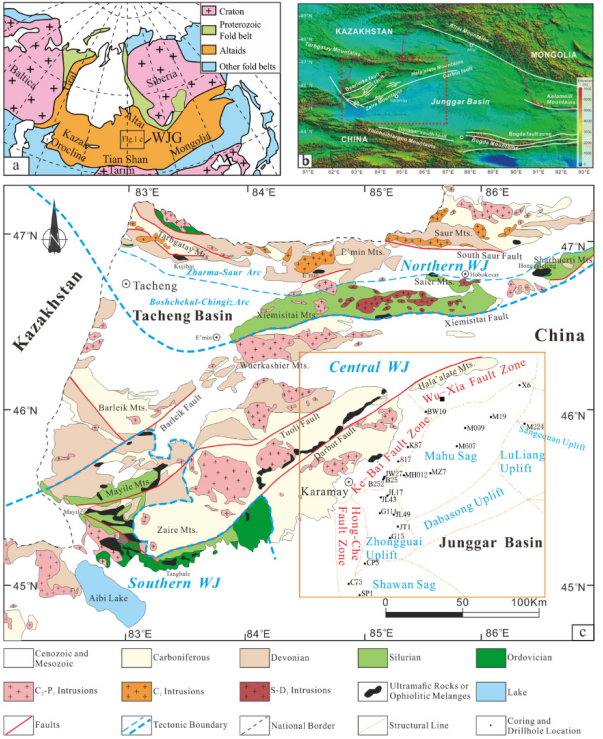
Figure 1. ( a ) Structural diagram of West Junggar and adjacent areas [53]. ( b ) Topographic map